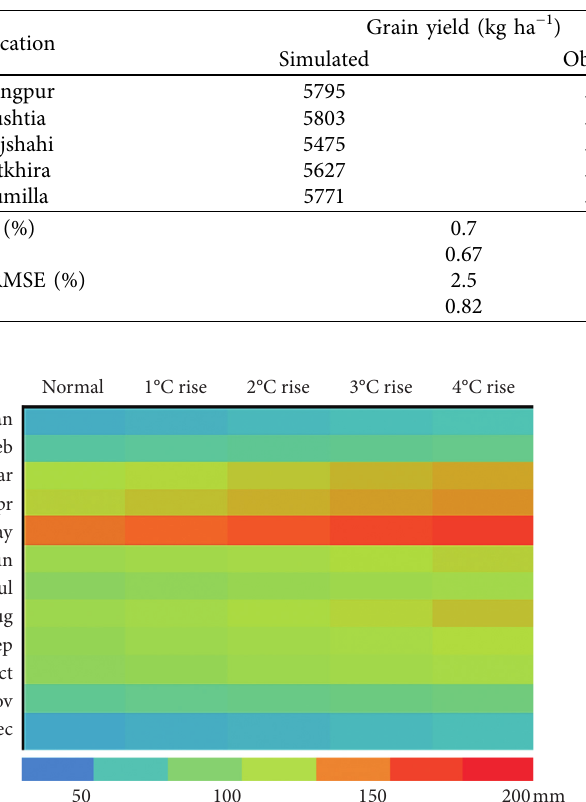
Table 6: Statistical evaluation of observed and simulated yield and growth duration of BRRI dhan28 for multilocation trial during 2014-15 for model validation.